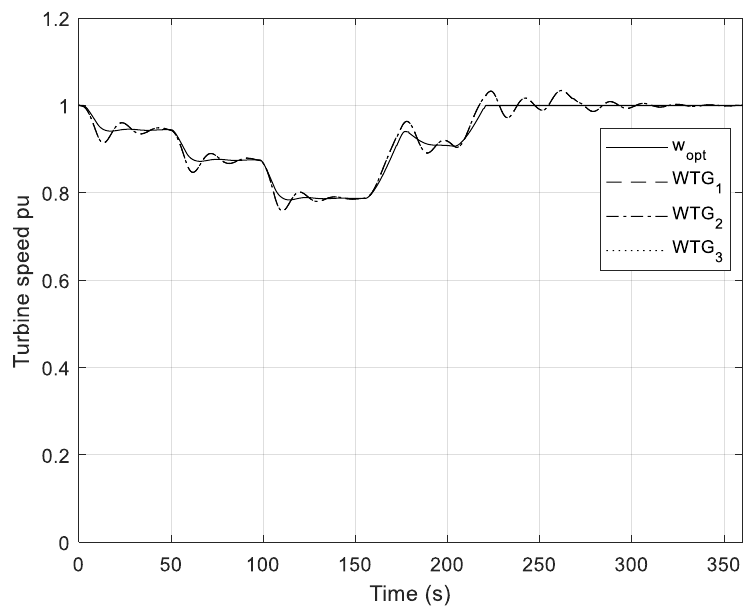
Figure 14. Reference (optimal) speed and speeds of WTGs.